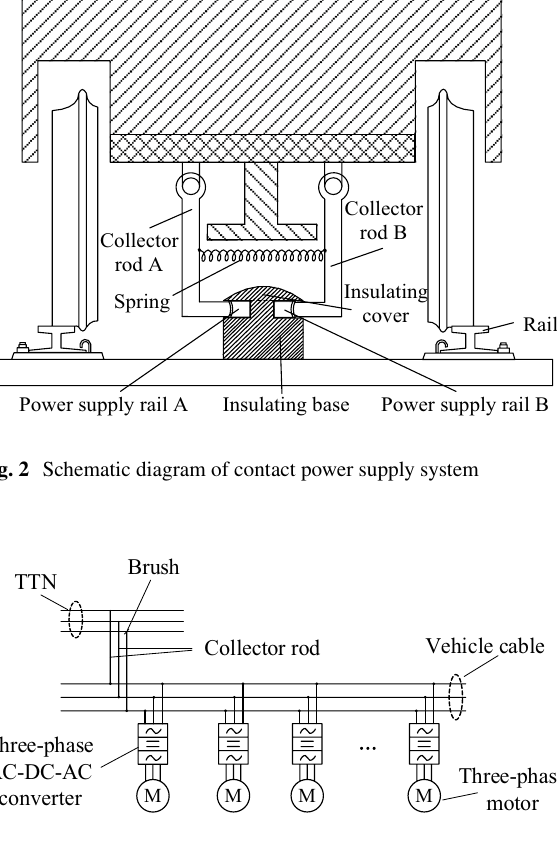
Fig. 3 Schematic diagram of vehicle power supply